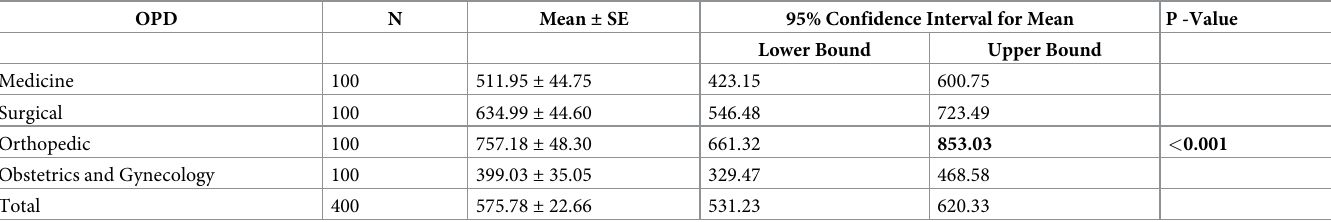
Table 7. Comparison of cost of nutraceutical prescribed department wise (One way ANOVA).